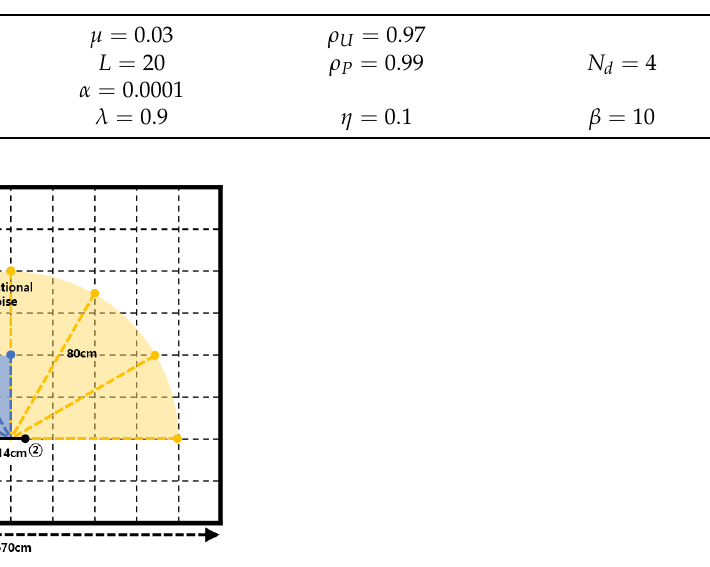
Figure 3. Room configurations with the locations of the microphones and the desired and interfer- ing